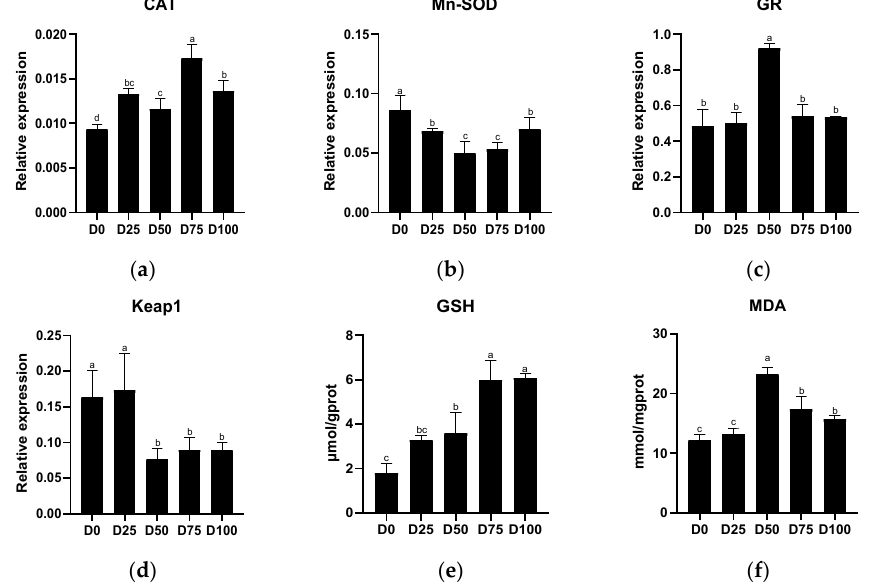
Figure 5. The effects of eugenol on antioxidant-related genes ( a ): CAT; ( b ): Mn-SOD; ( c ): GR; ( d ): Keap1, and antioxidant-related enzymes ( e ): GSH; ( f ): MDA, in gills of greater amberjack under simulated transport conditions. Different letters above bars indicate significant differences at the 0.05 level.